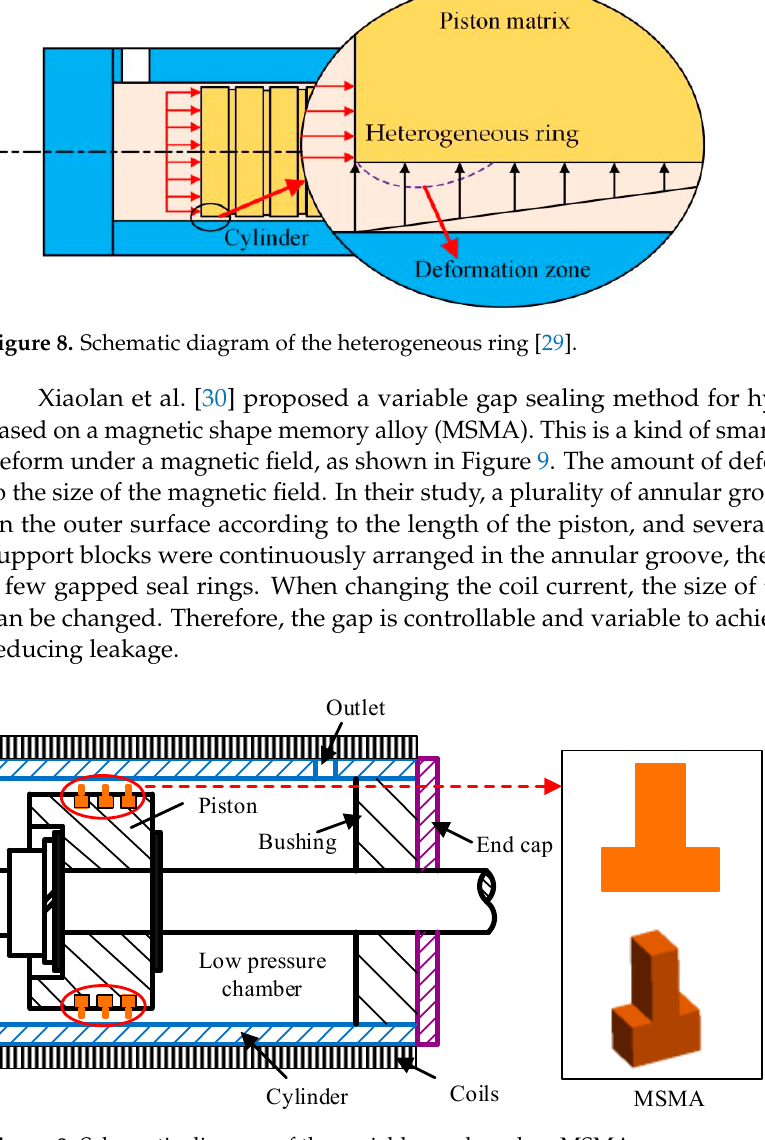
Figure 9. Schematic diagram of the variable gap based on MSMA .